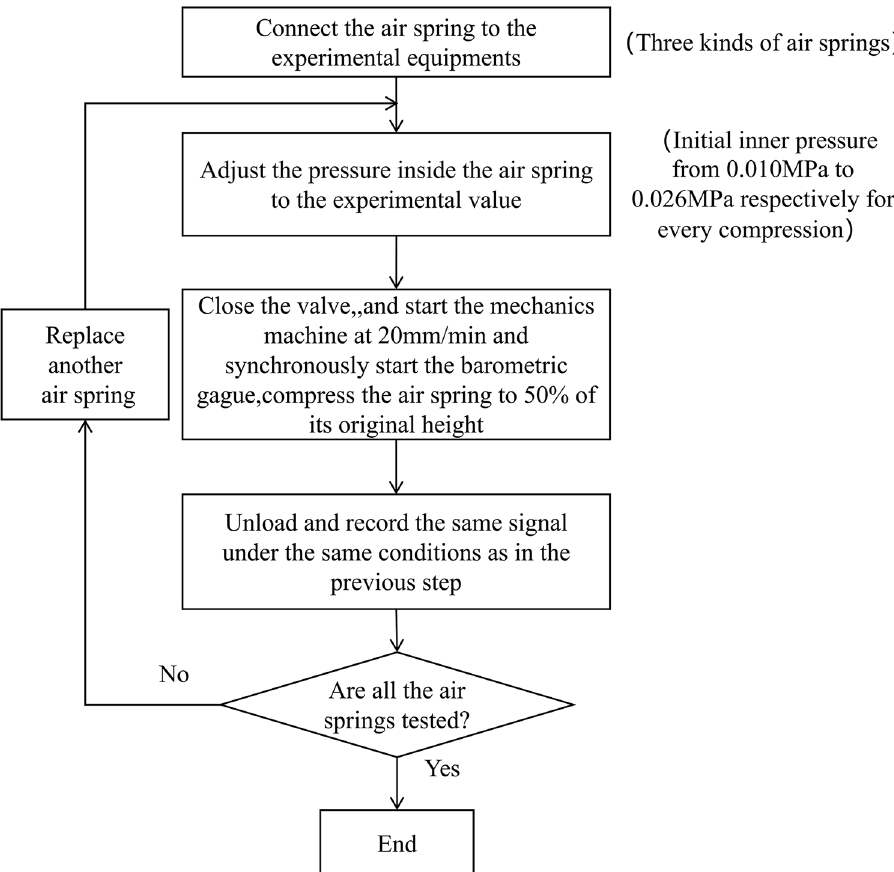
Fig. 3. Experimental